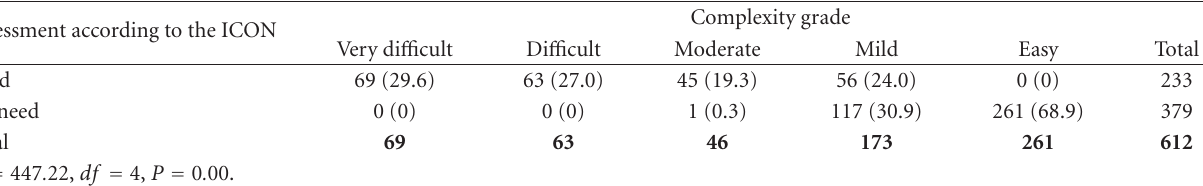
Table 3: Associations between orthodontic treatment need and complexity.